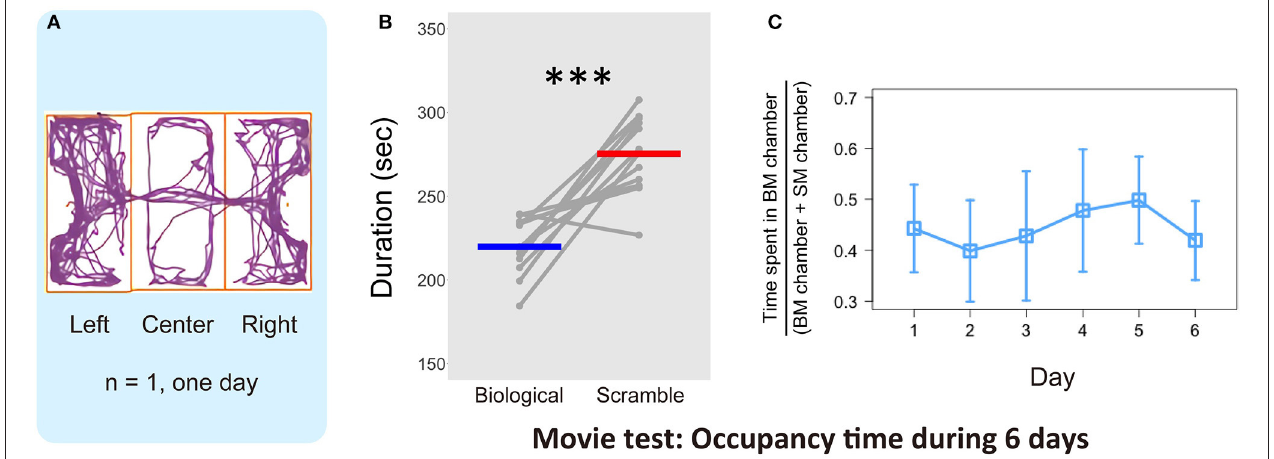
FIGURE 3 | Results of the time spent in the chambers with each stimulus in the Movie test. (A) One representative example of mouse locomotion for 10min in 1 day estimated by automated video tracking software. Purple line indicates the trajectory, and orange rectangles represent each chamber area. (B) Average time spent in each chamber over 6 days and individual plot of each mouse ( N = 12). Gray dots and lines indicate the individual data, and horizontal bars colored blue and red show the average time in each condition, respectively. The difference of the average time between Biological and Scramble movies was significant (*** p < 0.001). (C) Proportion of time spent in BM chamber across the 6 days ( N = 12). Error bars represent the ± 95% confidence interval of the